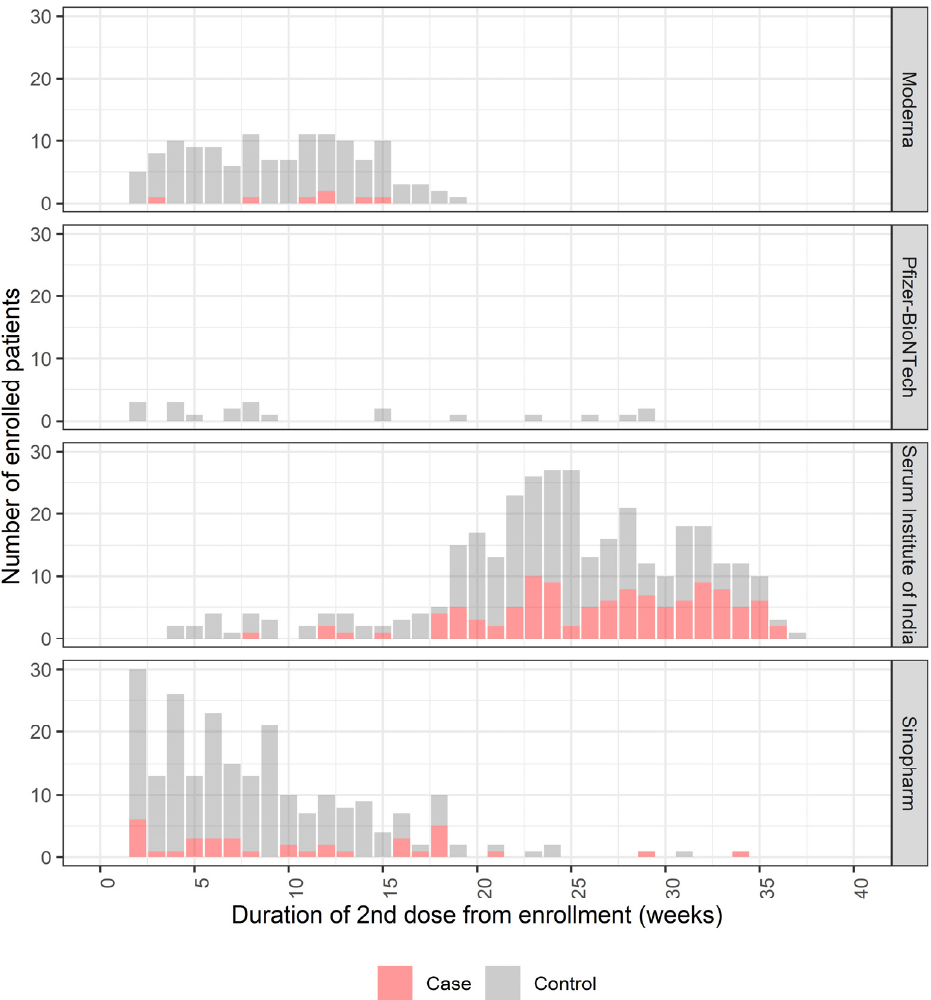
Figure 2. Vaccination of cases and controls by time since the second dose of vaccine in those with complete regimens (date of presentation at least 14 days after the second dose).